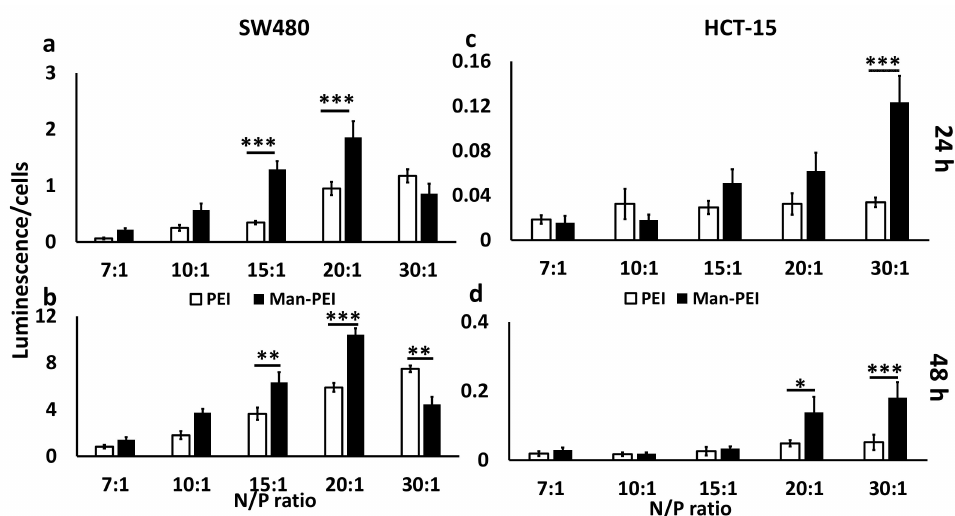
Figure 4. Expression of luciferase as detected by its bioluminescence following transfection of SW480 and HCT-15 cells with pGL-3 luciferase-expressing plasmid complexed with Man-PEI after 24 and 48 h. SW480 ( a , b ) and HCT-15 ( c , d ) cells were transfected with Man-PEI/pGL-3 complexes and luciferase expression was detected at for 24 ( a , c ) and 48 h ( b , d ); “Luminescence/% cells” indicates bioluminescence intensity over the number of live cells, as described in Methods section. *** p < 0.001; ** p < 0.01; * p < 0.05 between ( (cid:3) ) PEI and ( (cid:4) ) Man-PEI